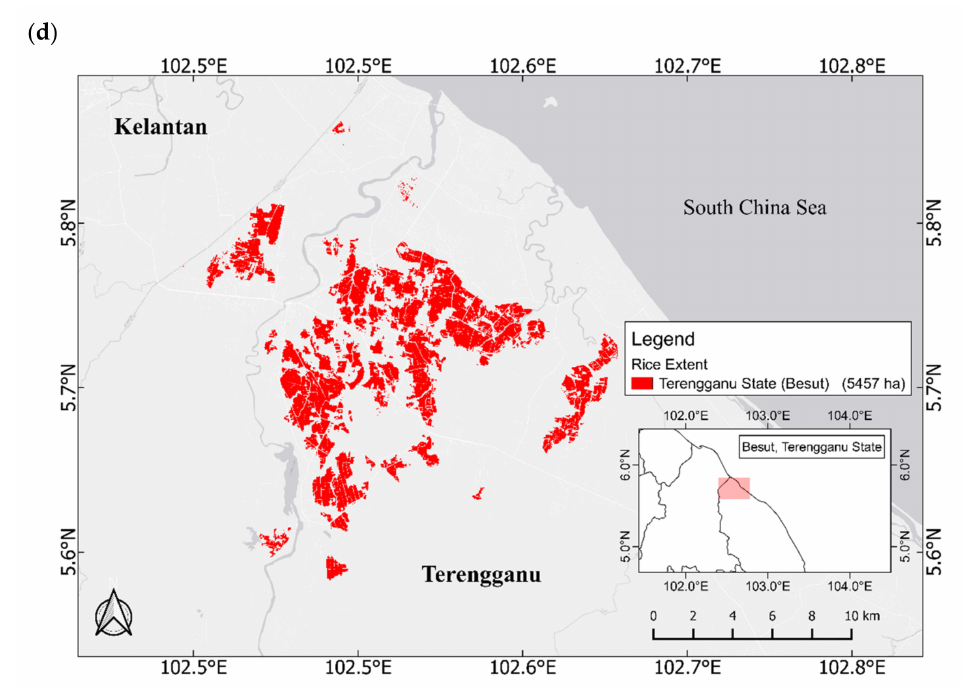
Figure 5. Map of rice field extent in ( a ) Selangor State, ( b ) Kedah and Perlis States, ( c ) Penang State, and ( d ) Besut district, Terengganu state.